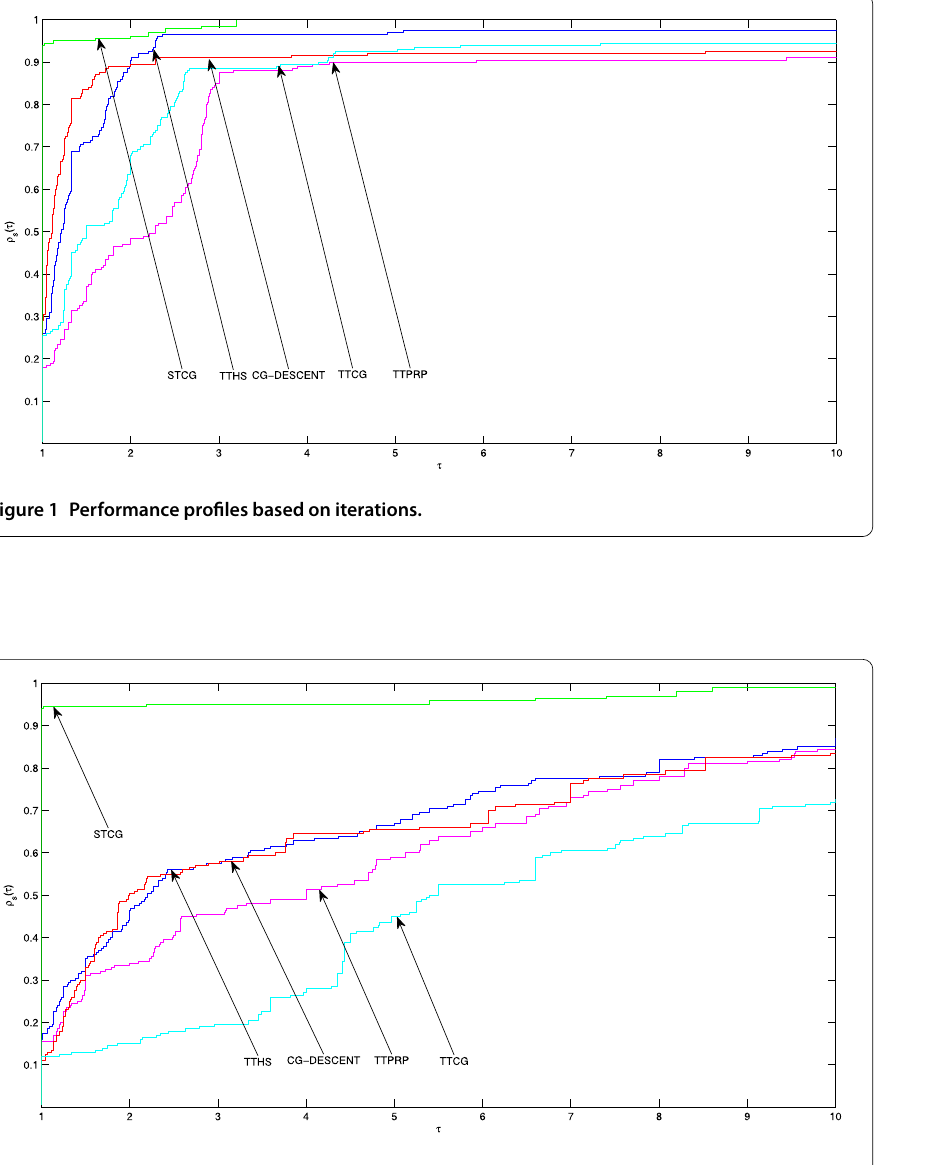
Figure 2 Performance profiles based on function